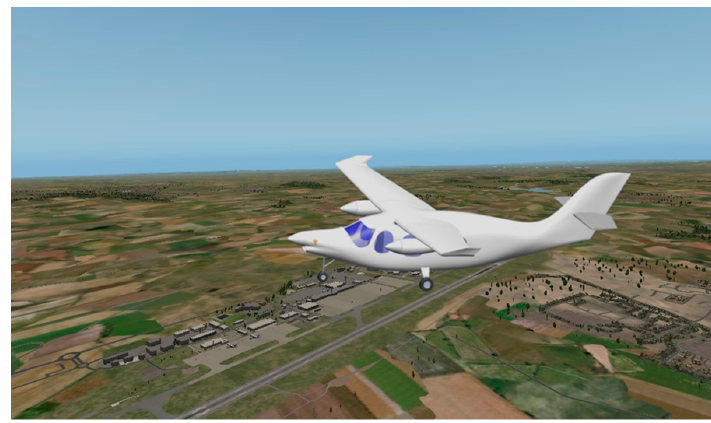
Figure 16. AUXX hybrid rendered model for X-Plane simulation.